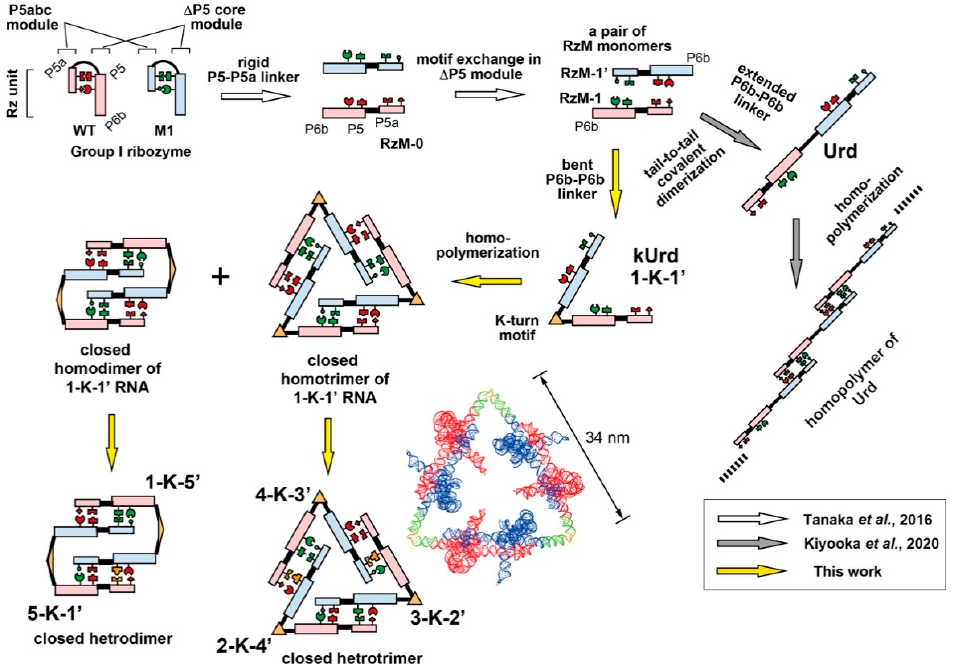
Figure 1. Design of closed oligomers based on engineered group I ribozyme dimers. Scheme of modular redesign to generate unit ribozyme dimers (kUrds) and their oligomerization. White arrows indicate structural redesign to prepare RzM RNAs and their noncovalent dimerization as reported by Tanaka et al. in 2016 [26]. Gray arrows indicate rational redesign for covalent dimerization of RzM RNAs reported by Kiyooka et al. in 2020 [28]. Yellow arrows indicate structural redesign to construct kUrd 1-K-1 (cid:48) in this study. Sequences and secondary structures of wild-type ribozyme, M1 variant ribozyme and their structural elements are shown in Figure